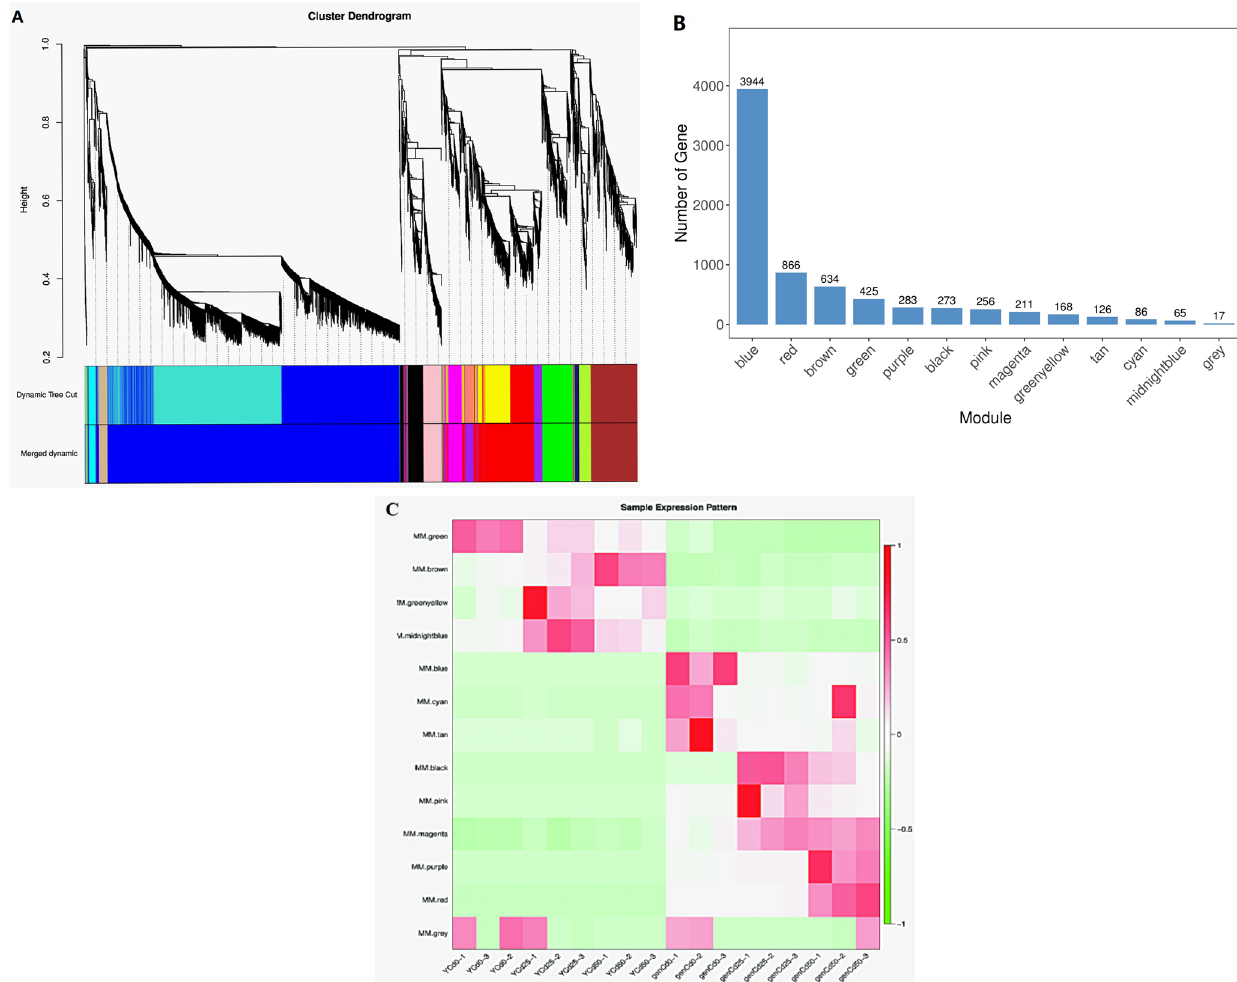
Figure 5. Co-expression network in goldenrain tree under cadmium stress. ( A ) Hierarchical cluster tree showing co-expression modules identified by weighted gene co-expression network analysis. Each leaf in the tree represents one gene. ( B ) Gene number in each module from ( A ). ( C ) Module–sample association for goldenrain tree treated with 0 mg/L, 25 mg/L, and 50 mg/L CdCl2 for 3 days. Y = leaves; gen = roots.